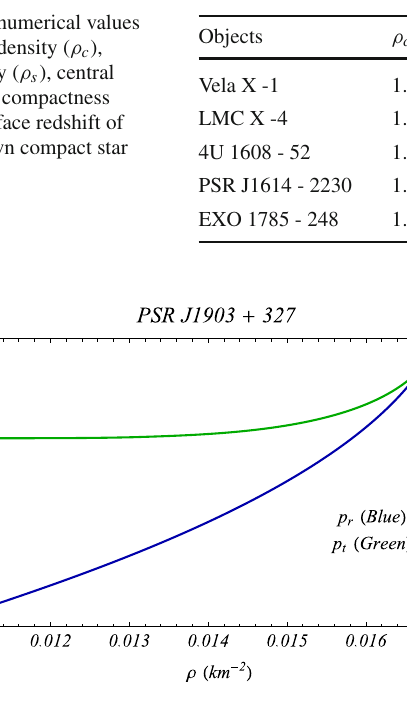
Fig. 6 The variations of radial and transverse pressure with respect to density are plotted for the compact star PSR J1903+327